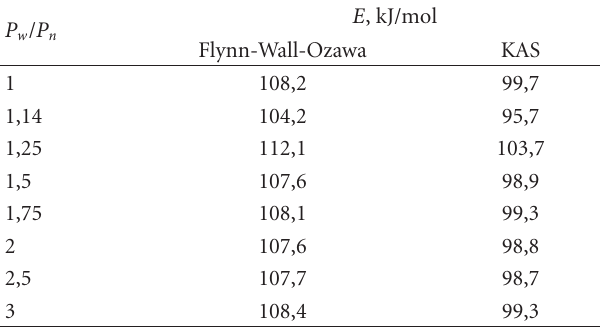
Table 4: Estimations of activation energy, obtained by isoconver- sion methods for arrays with di ff erent initial